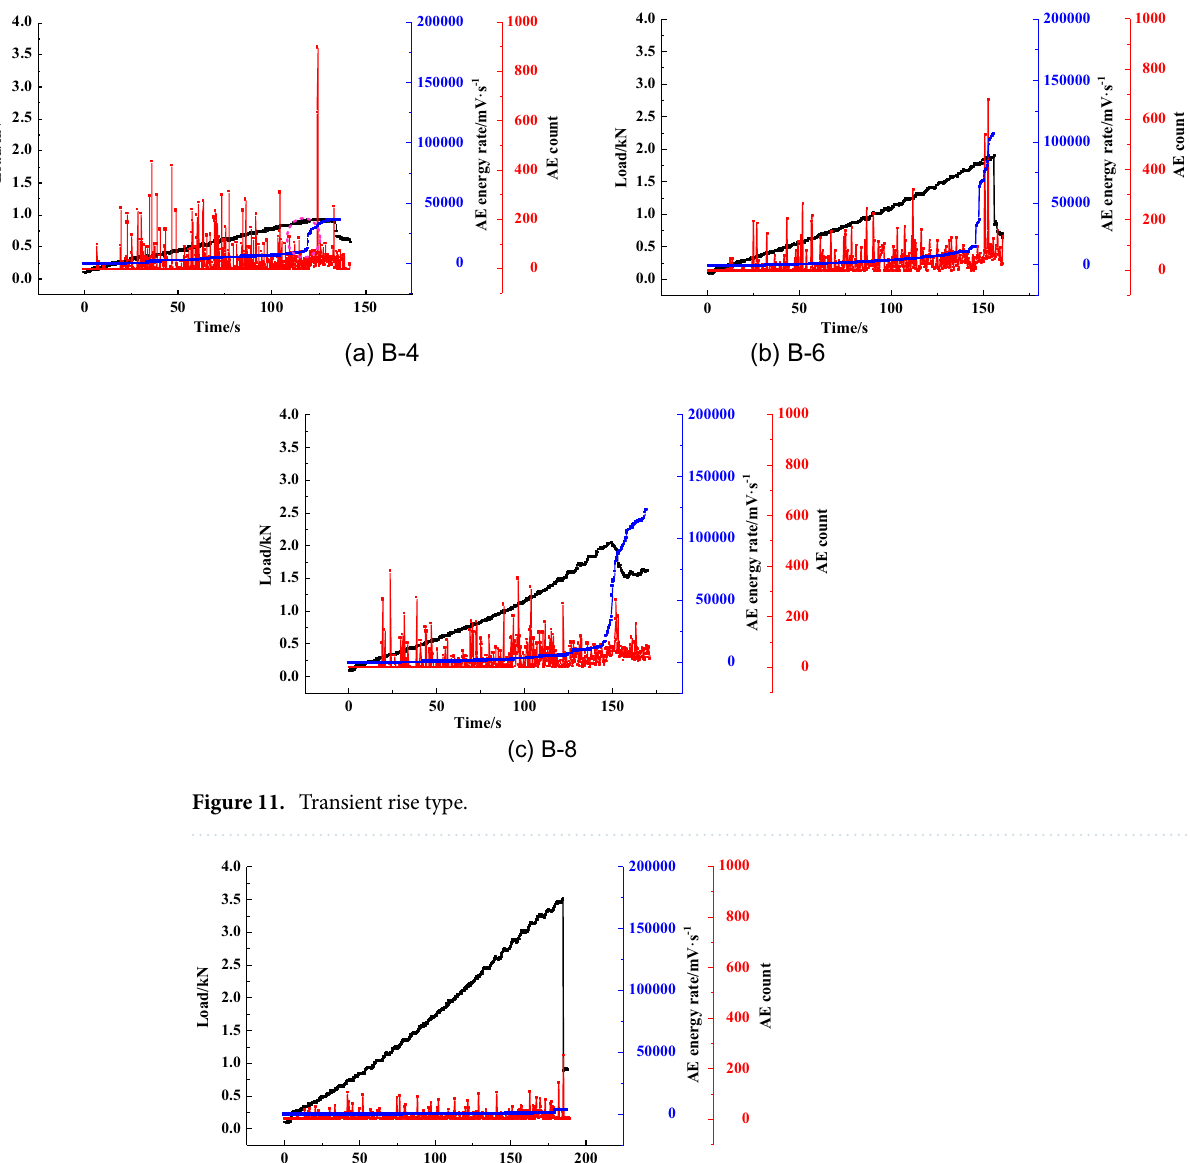
Figure 12. Steady rise